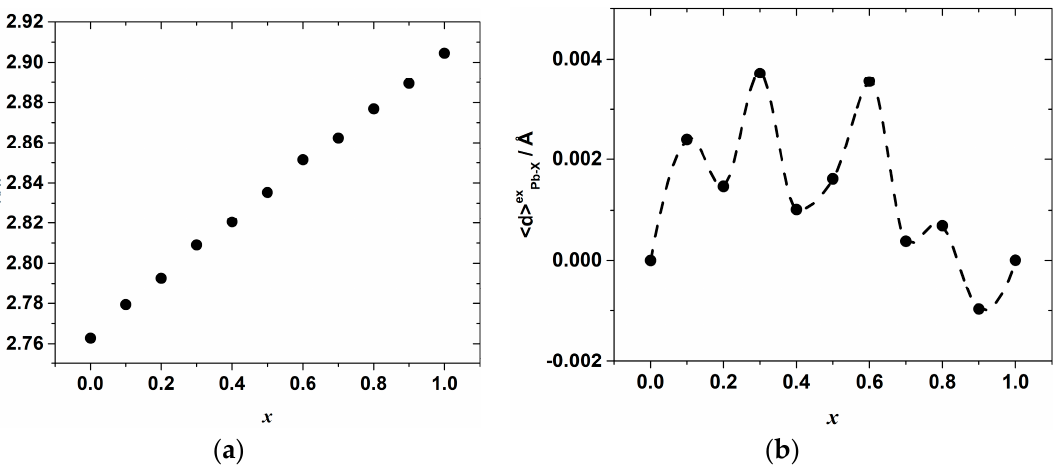
Figure 7. ( a ) The overall average Pb–X (X = Br, Cl) bond length and ( b ) its excess value as a function of composition, x , in CH 3 NH 3 Pb(Cl 1 − x Br x ) 3 .